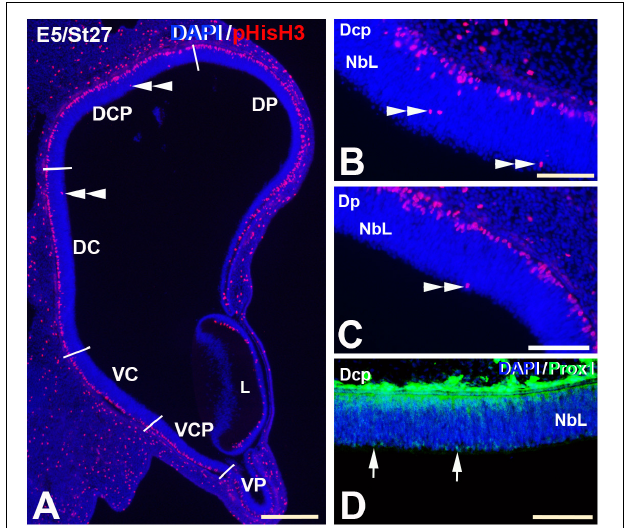
FIGURE 7 | pHisH3 (A–C) and Prox1 (D) immunolabeling in the E5 (St27) C. coturnix retina. Cryosections were counterstained with DAPI. (A–C) Non-apical mitosis were restricted to the D retina, mainly to the Dc and Dcp sectors (double arrowheads). Apical mitoses were abundant in the entire retina. (D) Prox1-positive nuclei were detected in close relationship with non-apical mitoses (arrows). Abbreviations: L, Lens; NbL, Neuroblastic layer. Scale bars: 100 µ m in panel (A) ; 50 µ m in panels (B–D) .